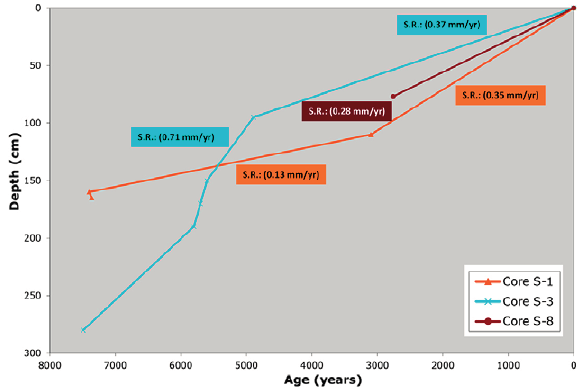
Fig. 5. – Age-depth model and sedimentation rates in mm/yr from cores S-1, S-3 and